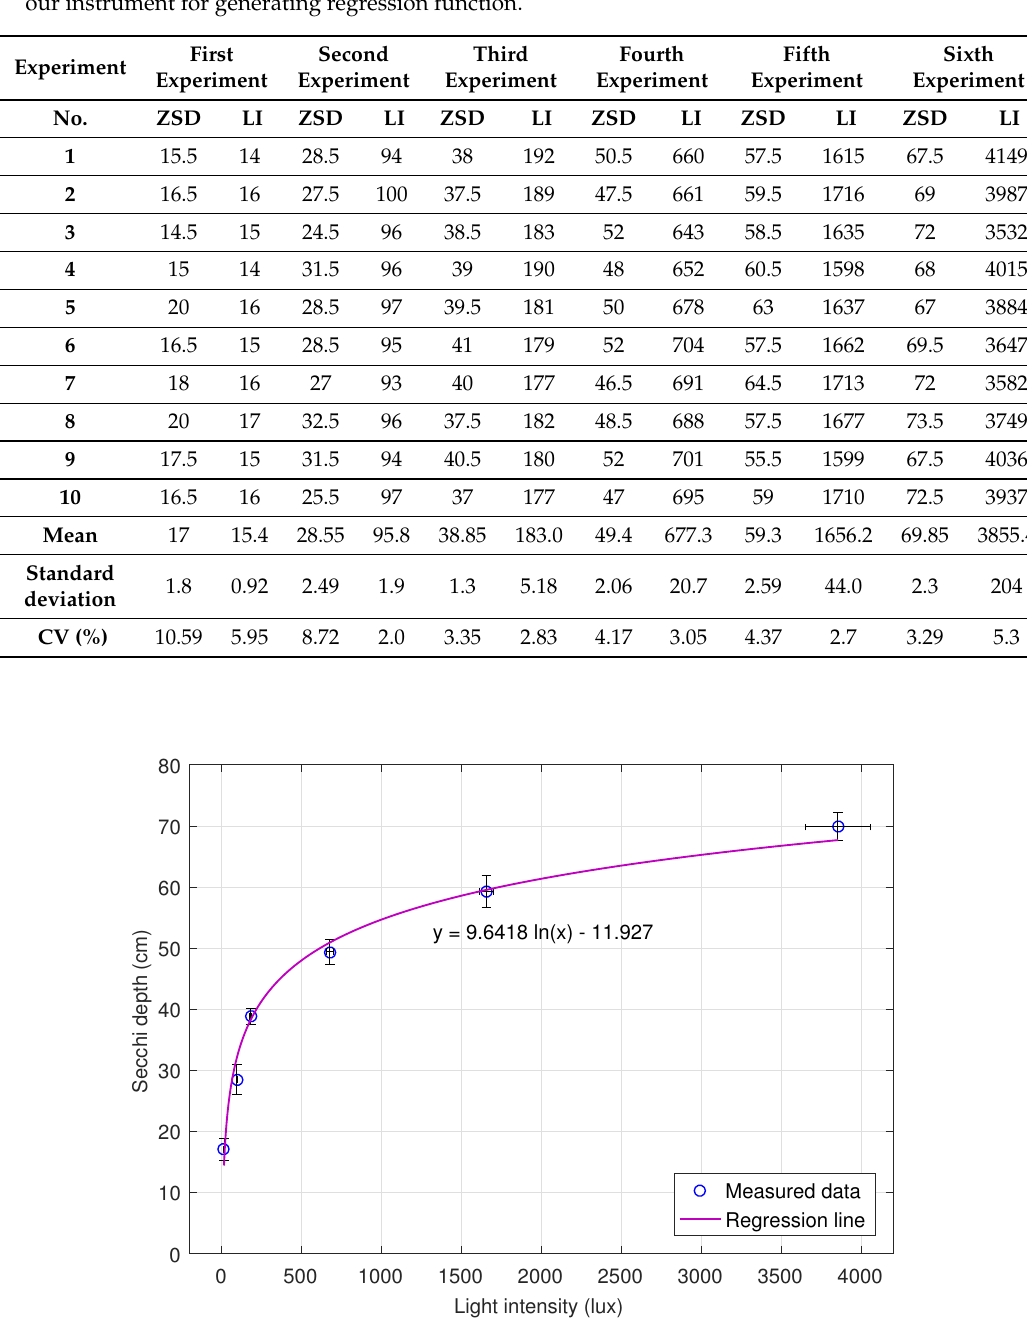
Table 1. Secchi depth (ZSD, cm) measured with naked eye and light intensity (LI, lux) measured with our instrument for generating regression function.